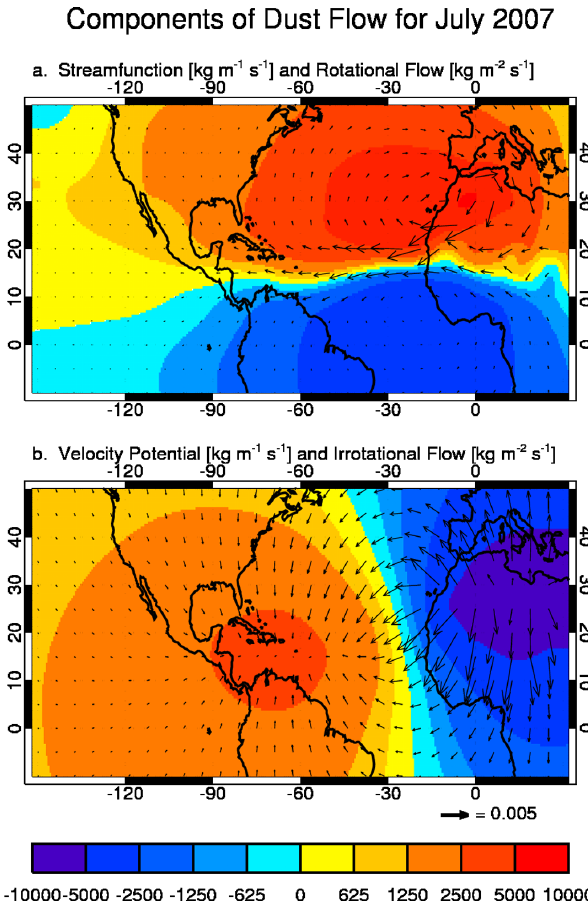
Fig. 10. (a) July 2007 ratio of wet removal to dry removal and (b) ratio of convective to large scale scavenging.